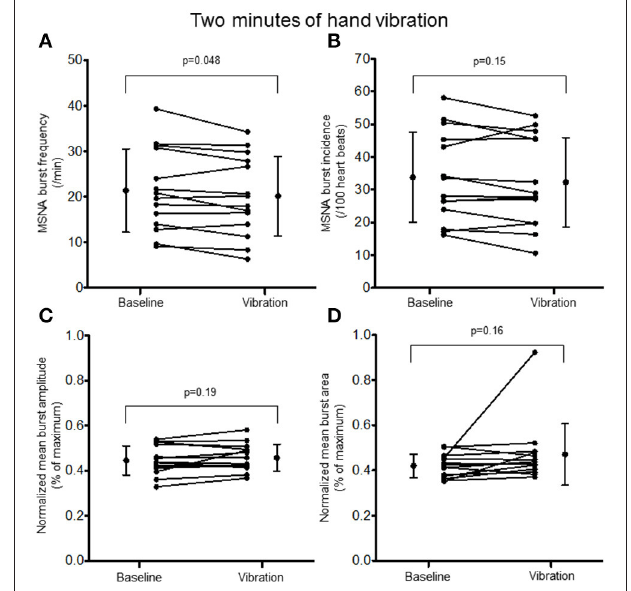
FIGURE 3 | Muscle sympathetic nerve activity (MSNA) burst frequency (A) , burst incidence (B) , and normalized mean burst amplitude (C) and area (D) during 2 min of baseline rest and hand vibration.